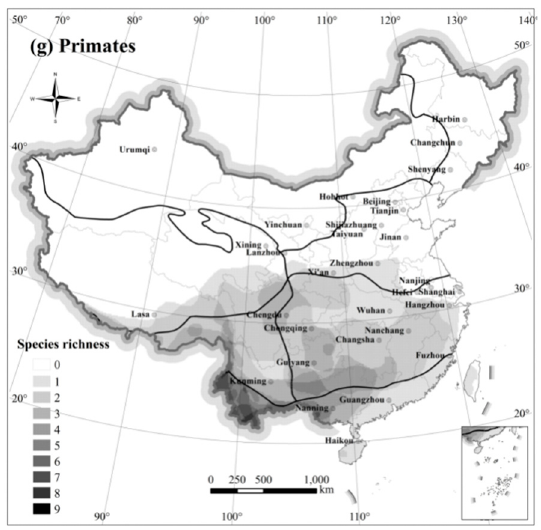
Figure 4. Spatial distribution of major mammalian order richness. ( a ) Carnivora; ( b ) Rodentia; ( c ) Cetartiodactyla; ( d ) Lagomorpha; ( e ) Chiroptera; ( f ) Eulipotyphla; ( g ) Primates.